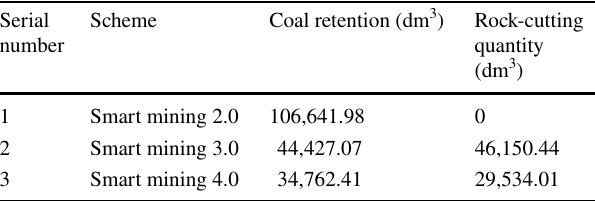
Fig. 15 3D schematic of the fully mechanized mining equipment workspace with three cutting schemes Table 2 Comparison of coal retention and rock-cutting volumes